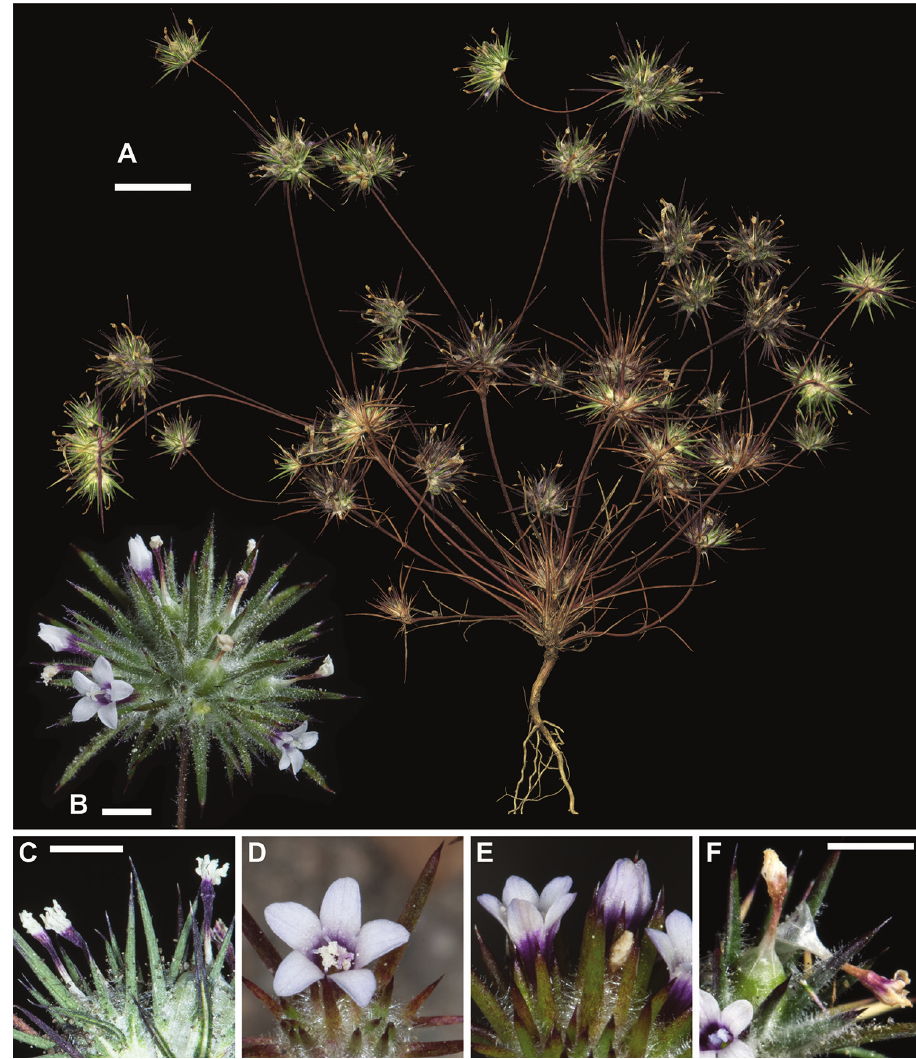
Figure 7. Navarretia torreyella . A Pressed specimen showing plant habit, scale bar = 1 cm ( Johnson et al, 13-230 ) B Flowering head in the field, scale bar = 2 mm ( Johnson 16-008 ) C–E Equivalent magnification, scale bar = 2mm. C Pressed flowering head showing coloration of dried flowers ( Johnson 16-008 ) D, E Fresh flowers showing coloration ( Johnson 13-218 ) F Fresh flowering head with maturing fruit, showing stretched corolla base that typically clings to fruit through maturity common in all of the species detailed herein, scale bar = 2 mm ( Johnson 16-008 ). All photographs by L. A. Johnson and vouchers deposited at BRY. tachment, the proximal nodes often congested with overlapping leaf bases. More distal leaves alternate, entire, or more commonly with 1–3 paired or unpaired linear lateral lobes 1–5 mm long attached along the proximal 3(–15) mm of the leaf, with an elongated, linear terminal segment. Inflorescences head-like, generally ≤ 10